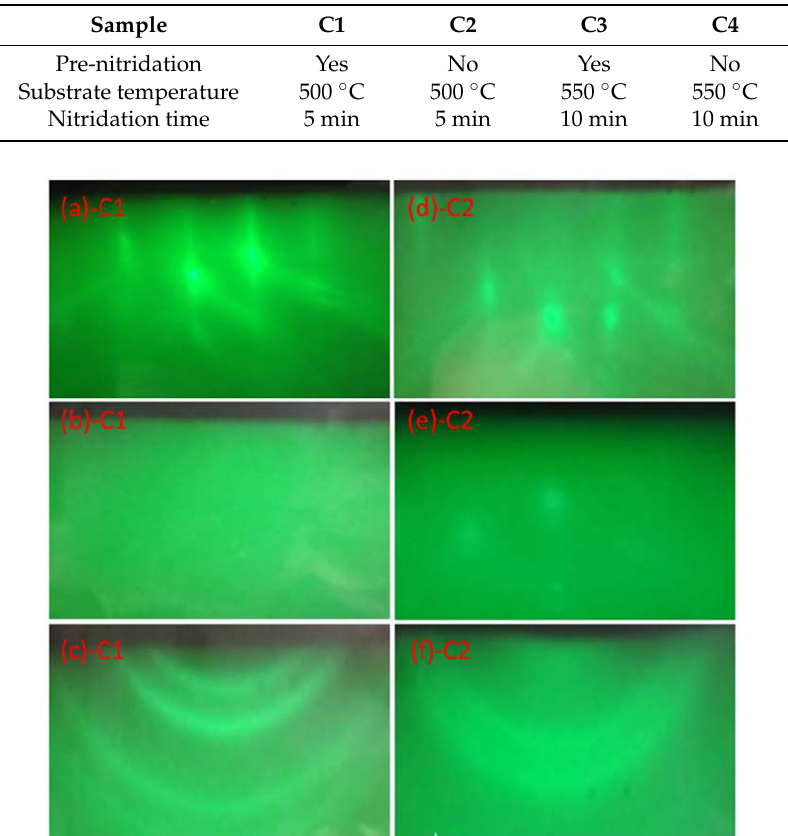
Table 1. The growth parameters of four samples.